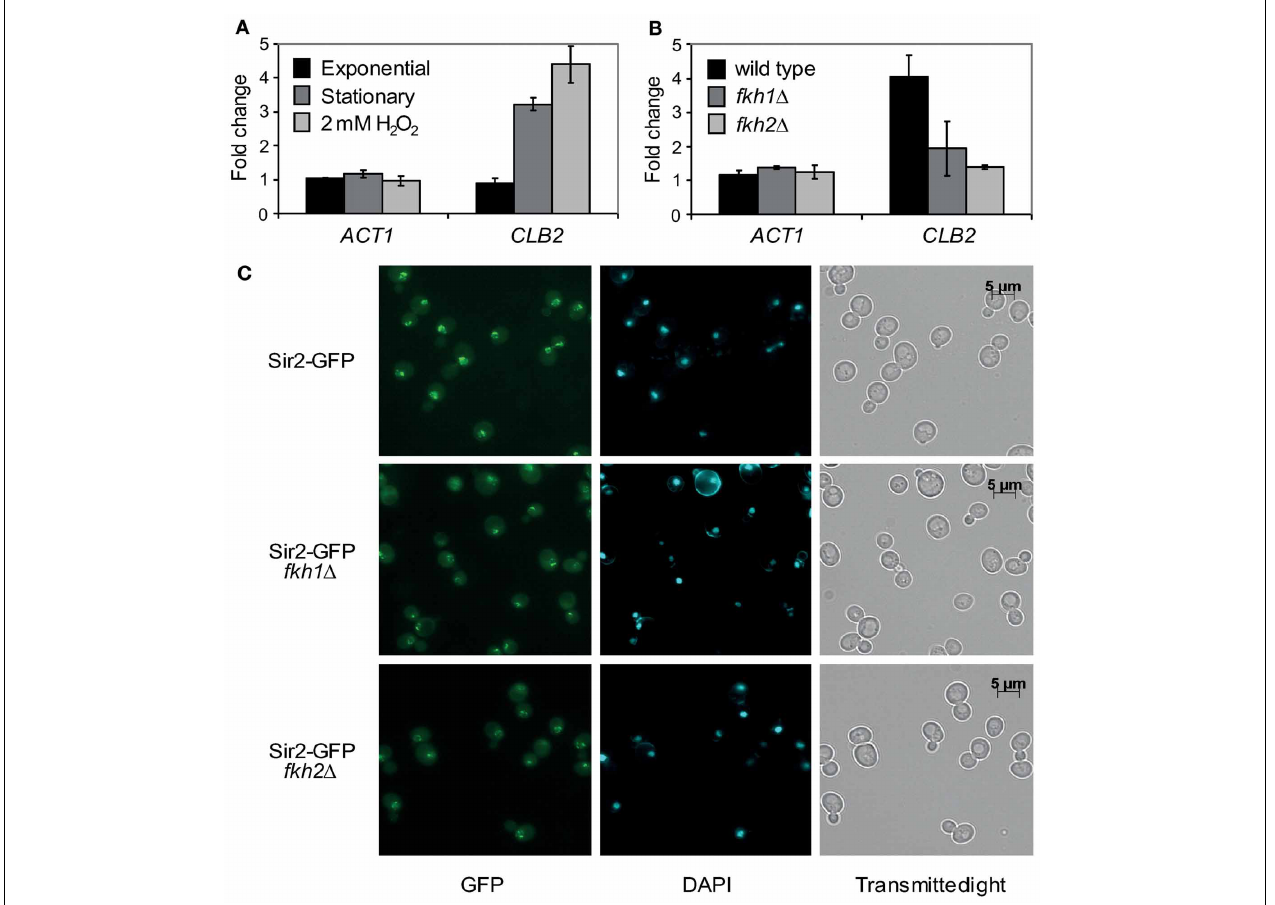
FIGURE 5 | Sir2 binds to the CLB2 promoter via Fkh1 and Fkh2 under stress conditions. (A,B) ChIP assay. (A) Haploid cells were grown to exponential phase (OD 600 ∼ 0 . 6), stationary phase (OD 600 ∼ 1 . 6) or treated with 2mM H 2 O 2 . Protein extracts were prepared and ChIP experiments were carried out using an anti-Myc antibody. The ACT1 gene was used as control. Each bar represents the mean average obtained from three independent experiments. (B) Haploid wild type and fkh1 (cid:2) or fkh2 (cid:2) cells